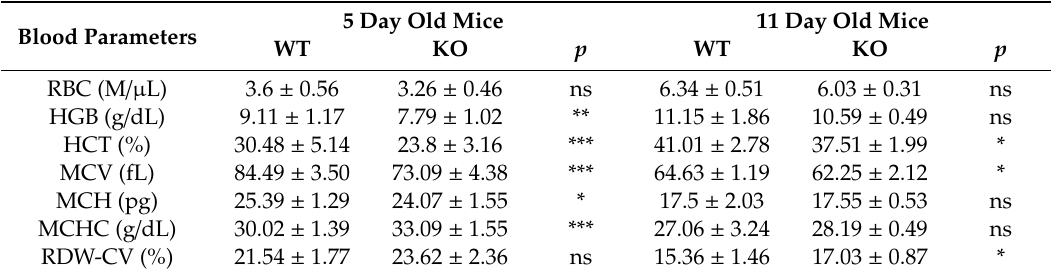
Table 1. Red blood cell (RBC) indices of 5 and 11 day old C57BL × FvB wild genotype (WT) and heme oxygenase 1 (HO1) knockout (KO) mice. Values are expressed as the means ± SD, n = 13 for 5 day old WT mice, n = 13 for 5 day old KO mice, n = 8 for 11 day old wild-type mice, and n = 8 for 11 day old Hmox1 knockout mice. To compare di ff erences in each blood parameter between wild-type (WT) and Hmox1 knockout (KO) groups at each time point, we used Student t -tests for datasets where distribution was normal and Mann–Whitney U tests where data distribution was not